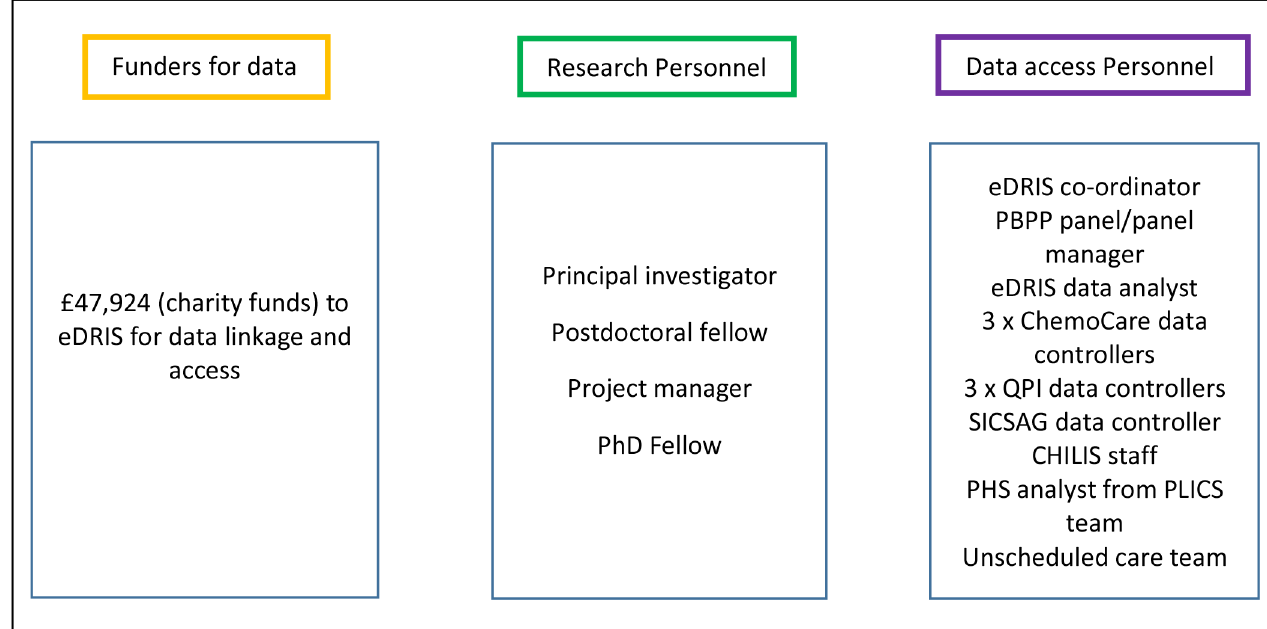
Figure 5: Direct costs and resource